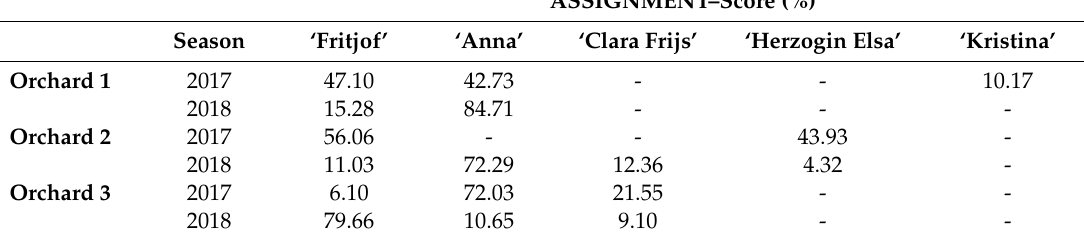
Table 5. Pollen contribution of individual pollinizer cultivars in three orchards and two seasons, identified through gene assignment within GeneClass 2 software [32]. X% of progeny was derived from Y pollinizer